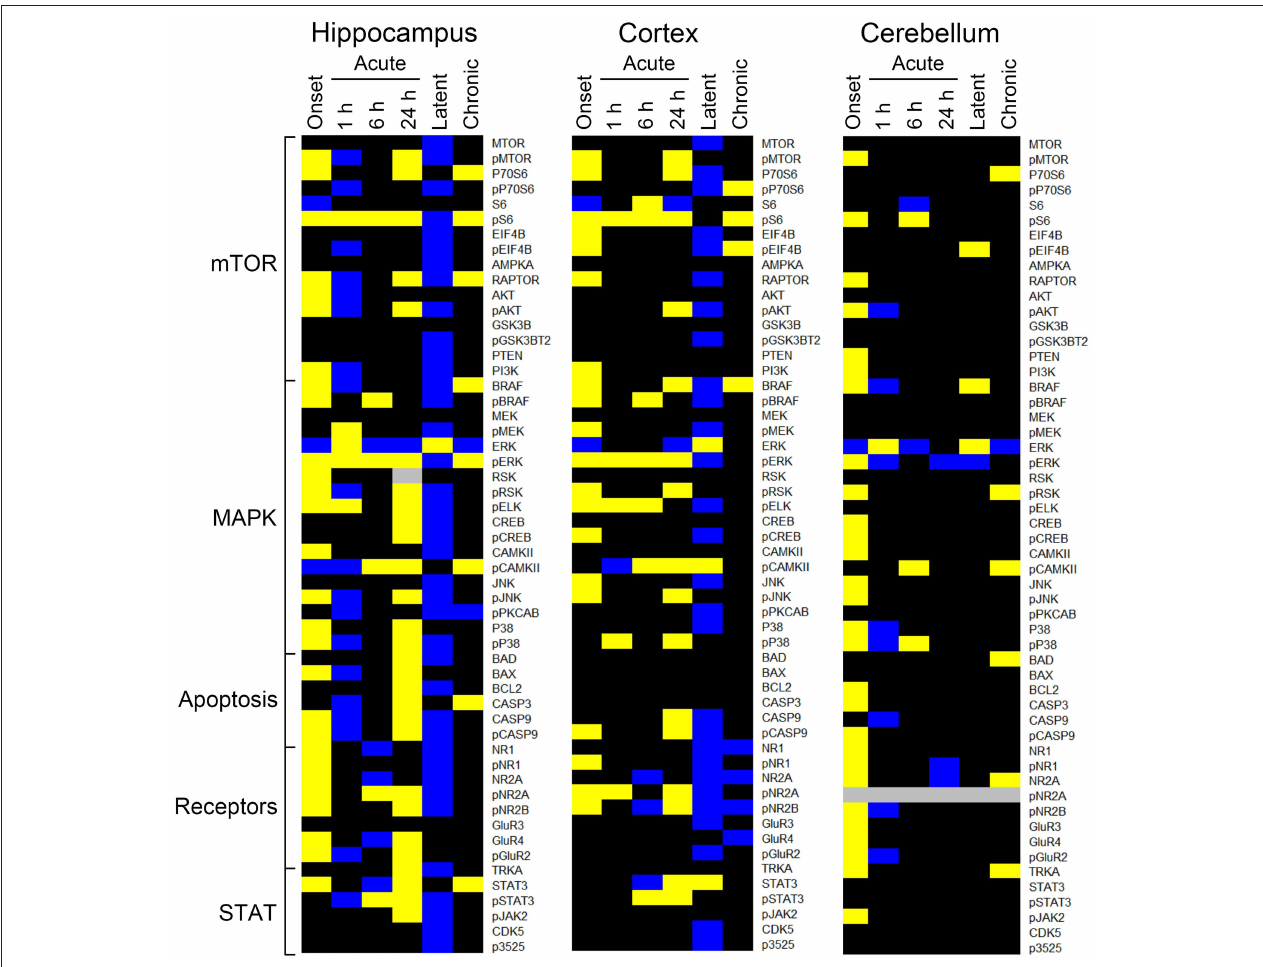
FIGURE 1 | Changes in protein expression during epileptogenesis. Heatmaps show proteins with an average expression level in pilocarpine treated mice significantly different from saline treated mice at the corresponding time points. Only proteins with differences ≥ 15% as determined by a three level mixed effects model, with p ≤ 0.0005, and a Benjamini-Hochberg correction for multiple testing applied with a false discovery rate of 0.05 are shown. Data derived from Supplementary Table 2 . Proteins are grouped by general category. Yellow, increased; blue, decreased; black, no difference; gray, not measured. n = 5 for each group, except for chronic pilocarpine where n =